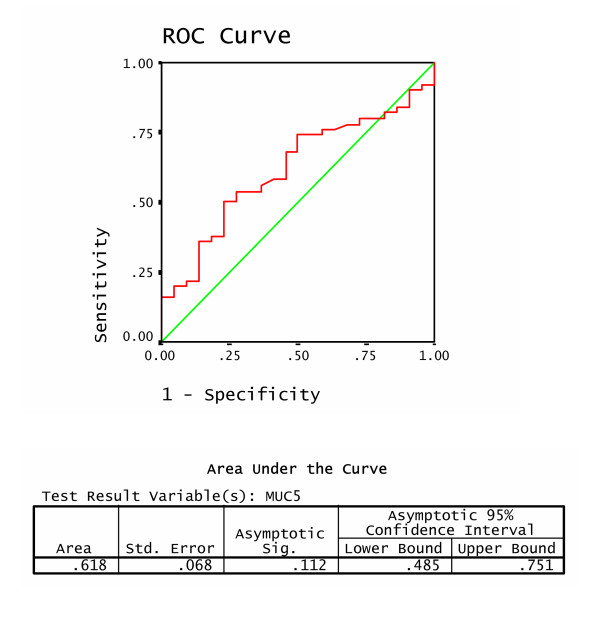
The ROC curve-comparing controls with colorectal carcinoma and polyp patients shows 0.618 of validity. ROC = receiving operating characterizing. The cut off level was taken as OD 0.225. At this value maximal sensitivity 54% and specificity 73% were attained.